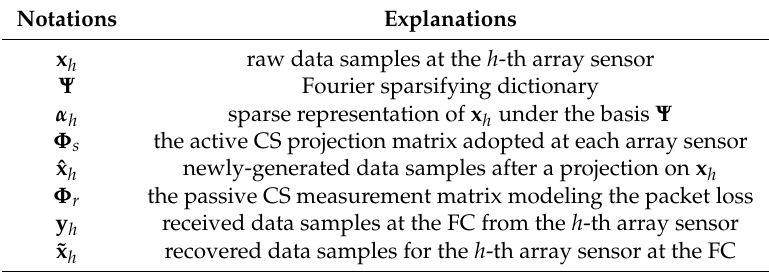
Figure 5. Schematic diagram of the double-layer compressive sensing (CS) framework and the DOA estimation process of DCS-DOA and DCS-direct DOA (DDOA). Table 1. Notations and explanations. FC, fusion